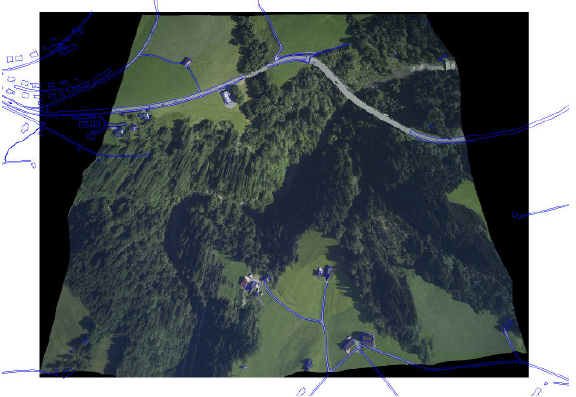
Figure 6: Quality check form of a differential rectified oblique image, superimposed by topographic features (e.g. Appenzell)